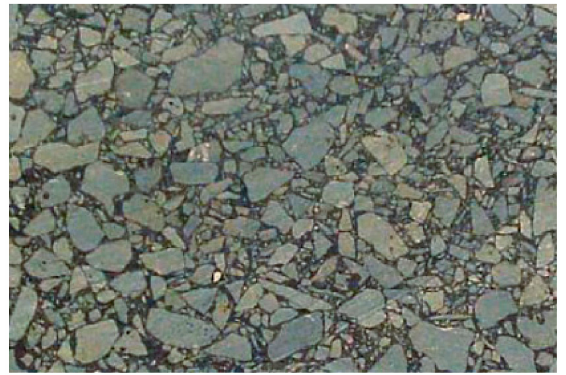
Figure 8. The inner section of a typical stone mastic asphalt (SMA) compacted layer